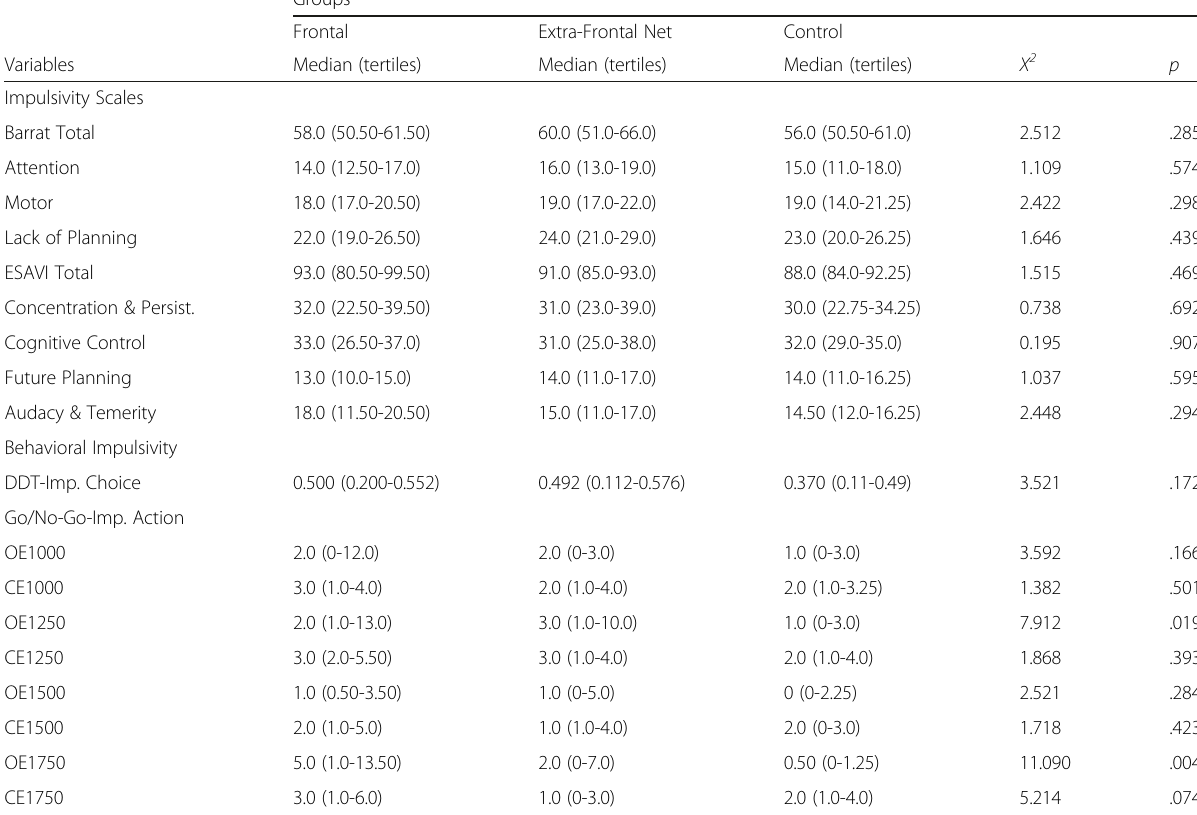
Table 2 Comparison among the three groups, regarding impulsivity Groups Frontal Extra-Frontal Net